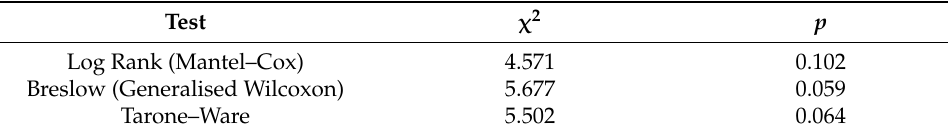
Figure 3. Survival rate of crowns according to position. Table 5. Test of survival distributions for three different crown positions.